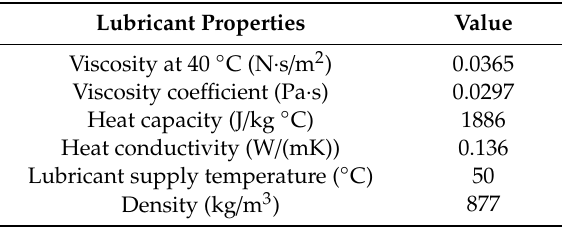
Table 1. Lubricant properties.